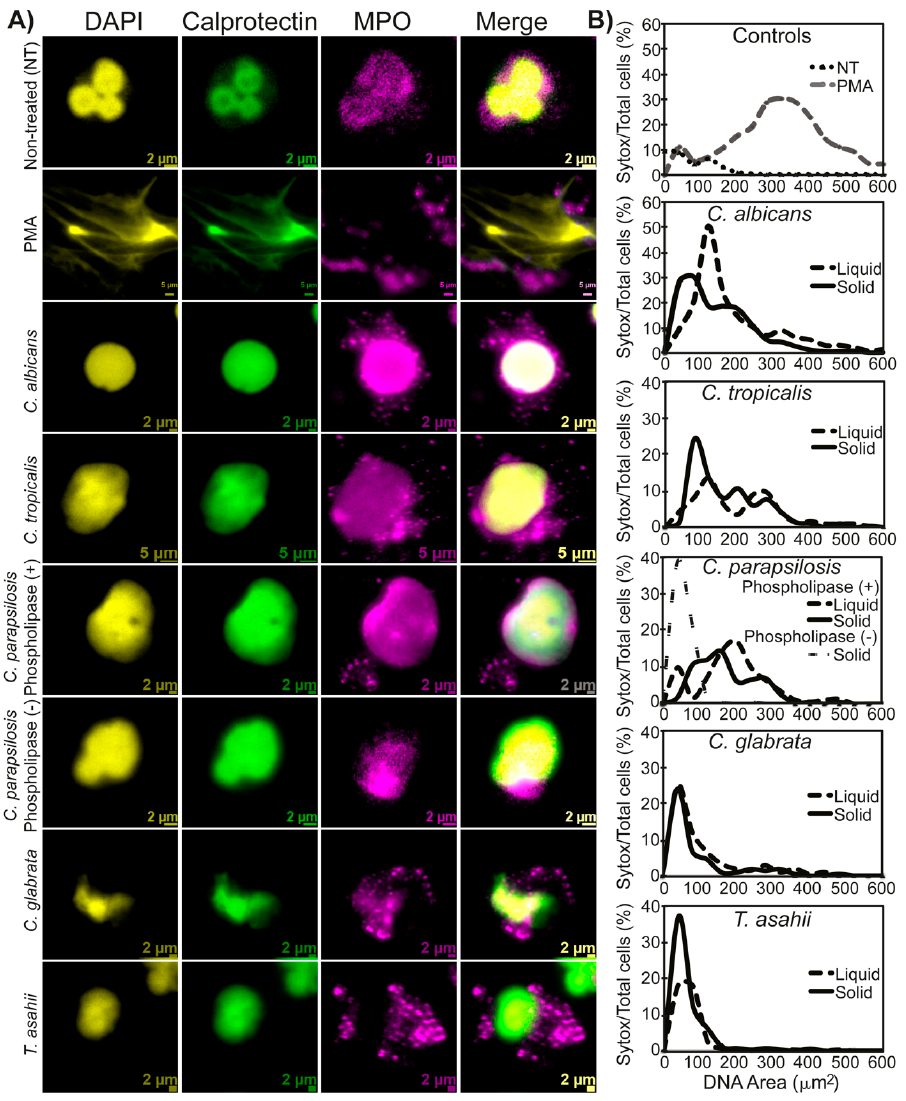
Figure 2. Nuclear changes and granule migration reminiscent of NETs occurred in neutrophils after treatment with C. albicans, C. tropicalis , and C. parapsilosis phospholipase positive, but not after incubation with C. glabrata or C. parapsilosis phospholipase negative strains. ( A ) Immunofluorescence microscopy images of neutrophils stained with myeloperoxidase (MPO) and calprotectin after treatment with PMA (positive control), non-treated (NT) or treated with C. albicans, C. tropicalis , C. glabrata , or with strains of C. parapsilosis producers of phospholipase or with phospholipase negative strains. In addition, for comparative purposes, neutrophils were incubated with a phospholipase negative strain of Trichosporon asahii for 180 min. To assess the nuclear morphology, the nucleus was stained with DAPI. From left to right, columns correspond to DAPI, calprotectin, MPO, and a merged image. ( B ) Nuclear area quantification of non-treated (NT) neutrophils or incubated with C. albicans , C. parapsilosis , C. tropicalis , C. glabrata , and Trichosporon asahii isolates grown on solid or liquid medium or PMA alone as a positive control. Additionally, a nuclear area quantification of neutrophils incubated with phospholipase-producing C. parapsilosis (+) or with a negative phospholipase strain (–) is shown. The nuclear area of neutrophils after stimulation was calculated as indicated in the Materials and Methods section, and the value corresponding to a given nuclear area range was plotted against the percentage of Sytox positive cells. Results are representative of three independent experiments and each condition was tested in